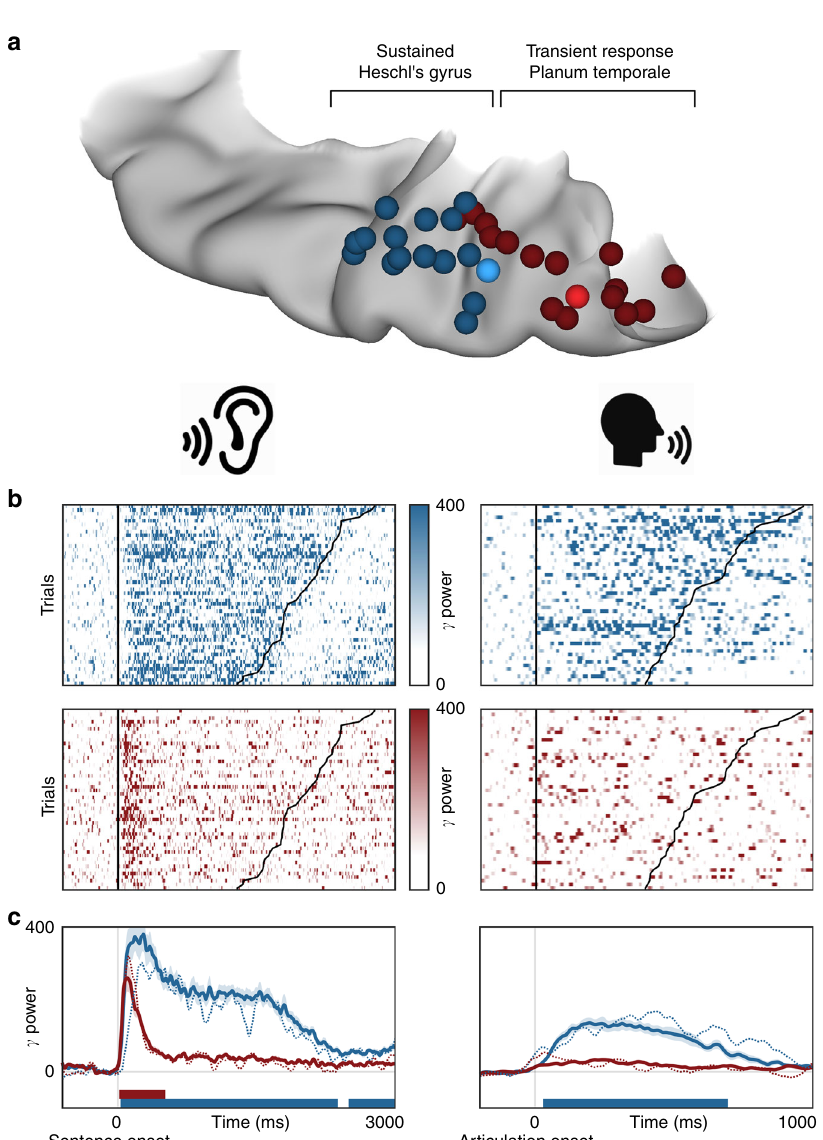
Fig. 7 Distinct supratemporal responses during speech listening and articulation. Functional dissociation in HG/TTS and PT during listening and speaking. a A pair of electrodes were selected in each patient for a sustained (blue) and transient (red) response to the 3 Hz amplitude-modulated white noise stimulus. One representative patient was highlighted (bright electrode pair) for single-trial analysis. b Single-trial raster plots of the percent change in high-gamma power during speech listening and production. c High-gamma power averaged across trials and then across patients. Signi fi cance was determined with the Wilcoxon signed-rank test at an alpha level of p < 0.001 using familywise error correction. The mean activity from the representative individual highlighted in panel b is included as the dotted line. While the high-gamma response in HG/TTS is reduced during articulation, the response in PT is